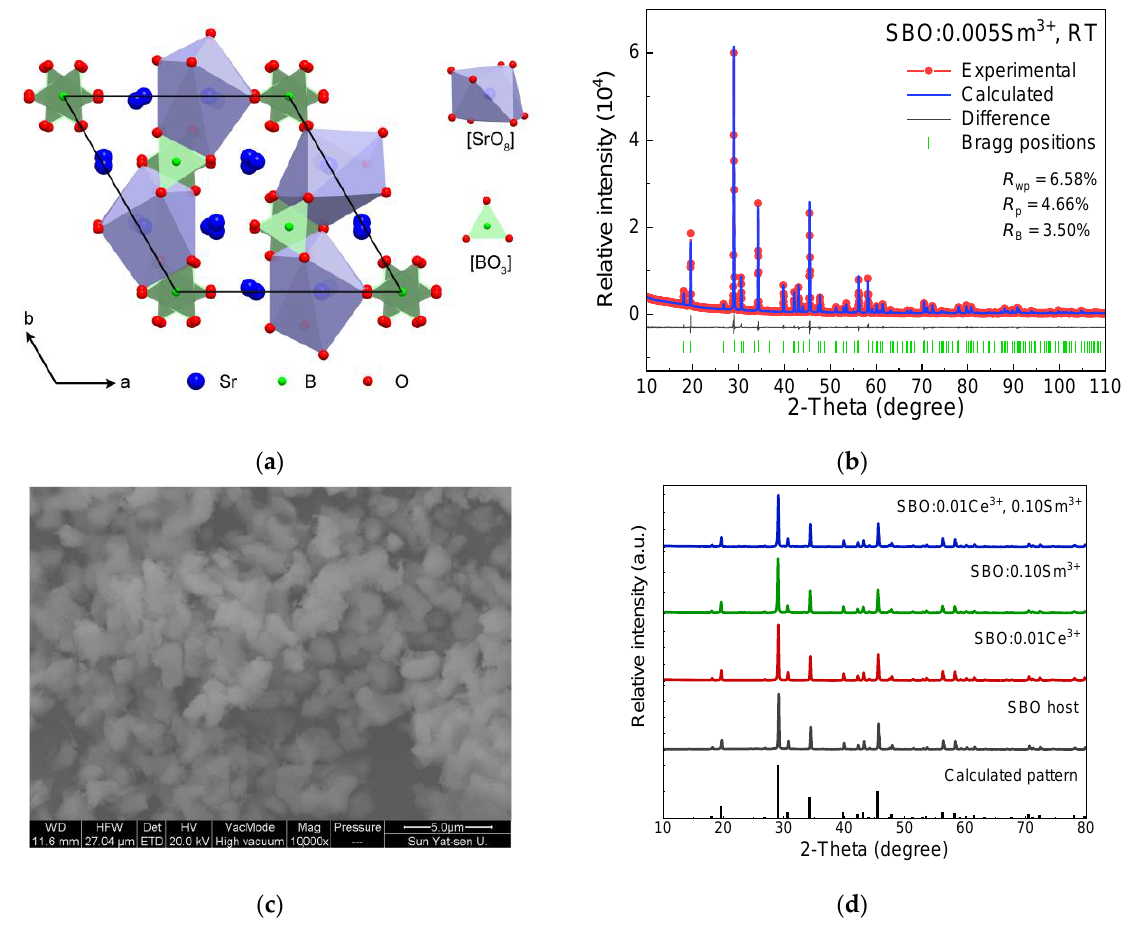
Figure 1. ( a ) Crystal structure along c -axis of Sr 3 B 2 O 6 host as well as [SrO 8 ] polyhedron and [BO 3 ] triangle; ( b ) Rietveld refinement of SBO:0.005Sm 3+ XRD data at RT; ( c ) Scanning electron microscope (SEM) image of SBO:0.005Sm 3+ sample; ( d ) XRD patterns of some typical